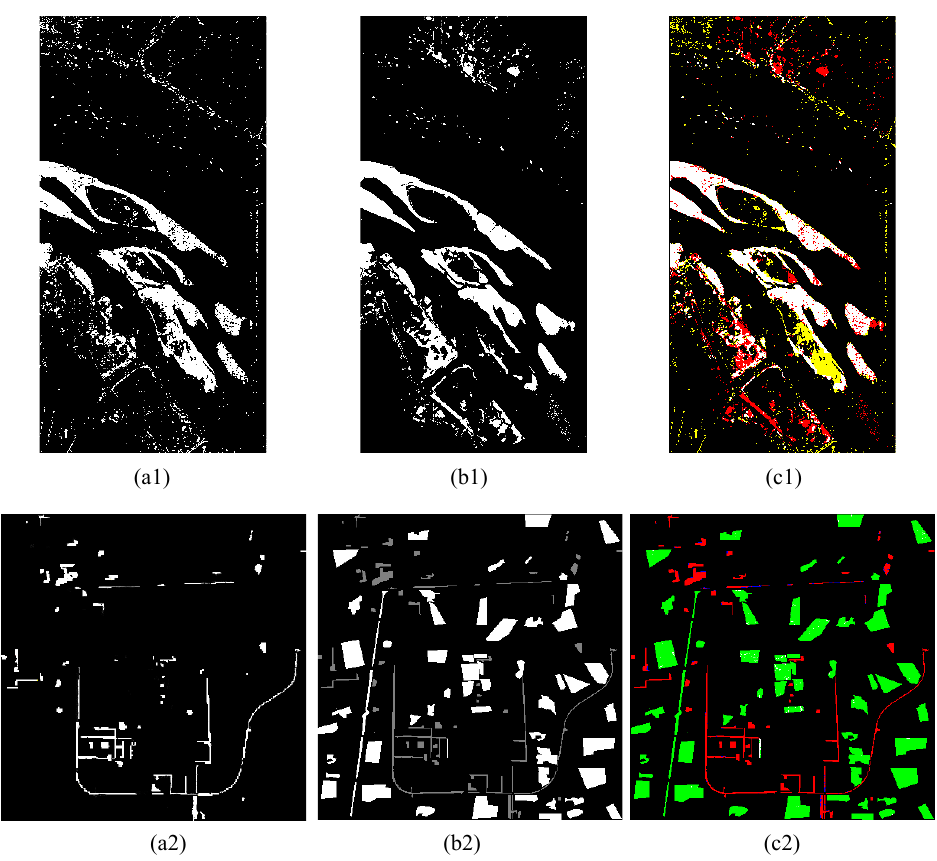
Figure 5. Visualization of Hitting Status Maps; ( a 1) and ( a 2): the two random Binary Alteration Map of datasets ‘River’ and ‘Taizhou’; ( b 1) and ( b 2): the corresponding ground truth maps; ( c 1) and ( c 2): the corresponding Hitting Status Maps.